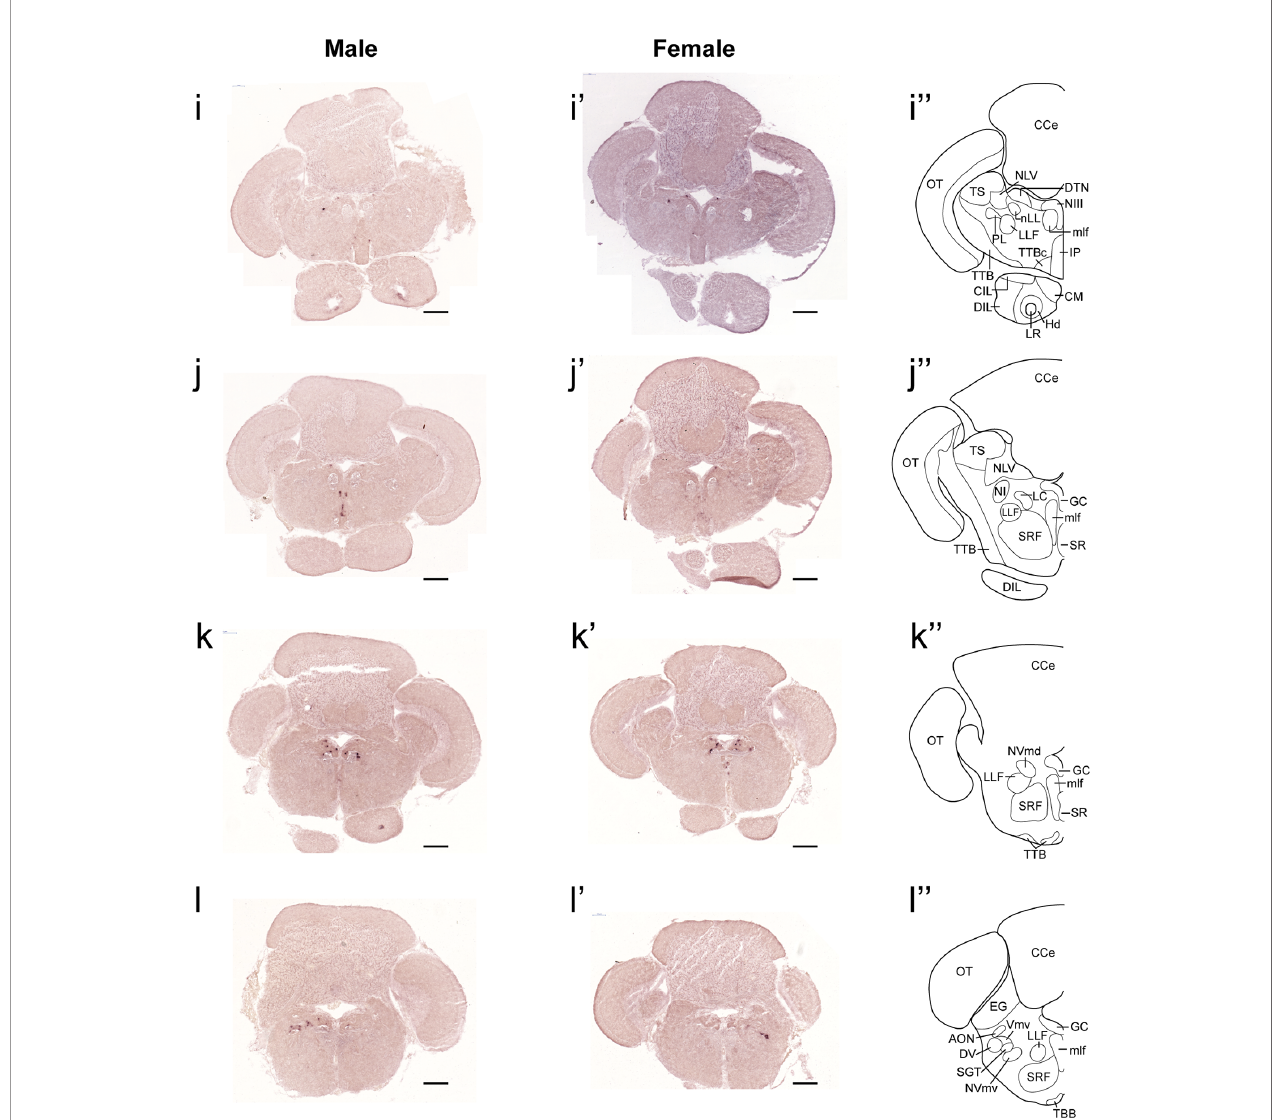
FIGURE 3 | Comparison of expression patterns of tac1 mRNA in the hindbrain regions of male (I − L) and female (I ’ − L ’ ) zebra fi sh. In the most-right panels (I ” − L ” ) , a schematic drawing of half of the brain section (left side) processed for tac1 staining indicating major brain structures at this level. There was no sex difference in expression of tac1 in the mesencephalic and rhombencephalic regions including the interpeduncular nucleus, dorsal tegmental nucleus, central gray, and trigeminal motor nucleus, while in the superior raphe, there was more tac1 expression in males as compared to females (J , J ’ ) . Scale bars: 200 µm. See glossary for